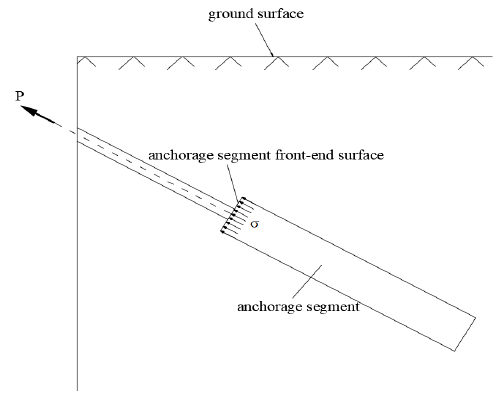
Figure 2. Stress diagram of anchorage segment front-end surface.